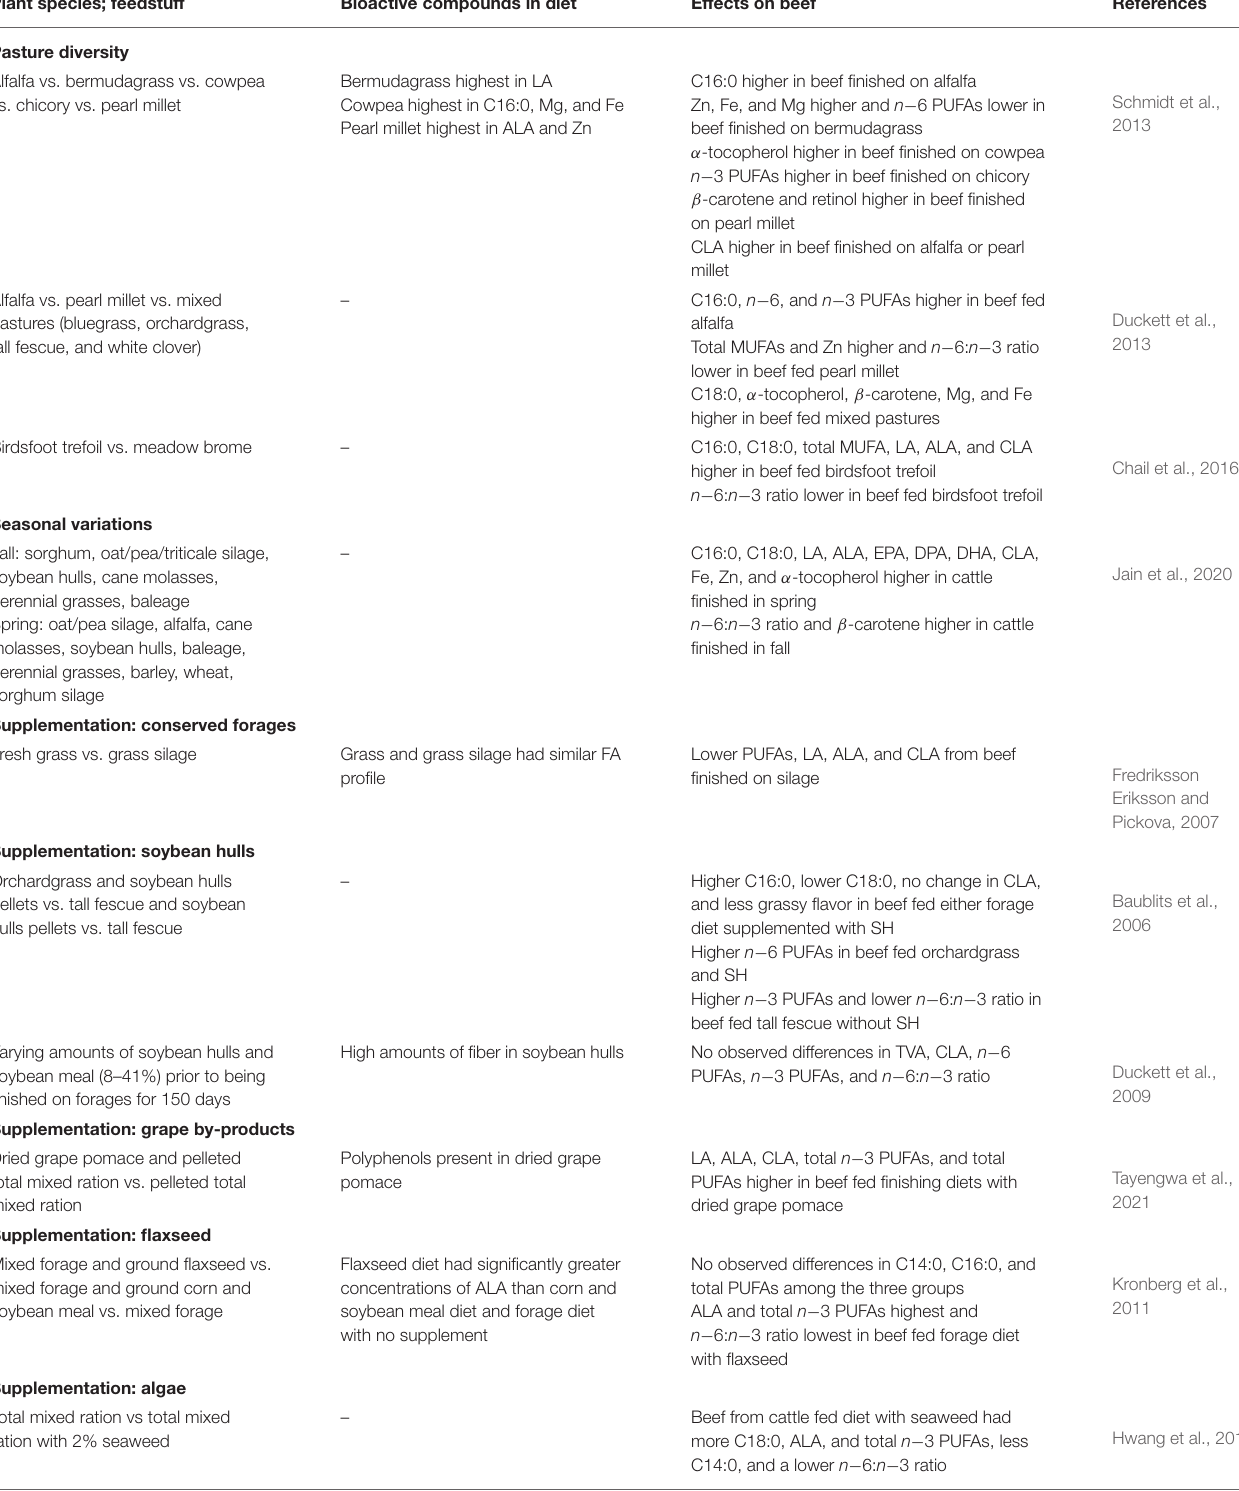
TABLE 1 | Effects of various feedstuff and their bioactive compounds on the nutritional profile of beef. Plant species;